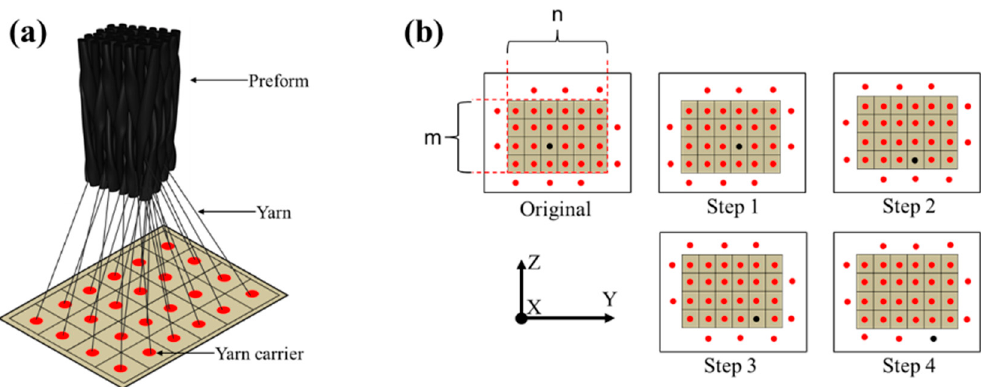
Figure 1. The schematic of: ( a ) the sketch map and ( b ) the yarn carrier movement in the 4×4 braiding process.